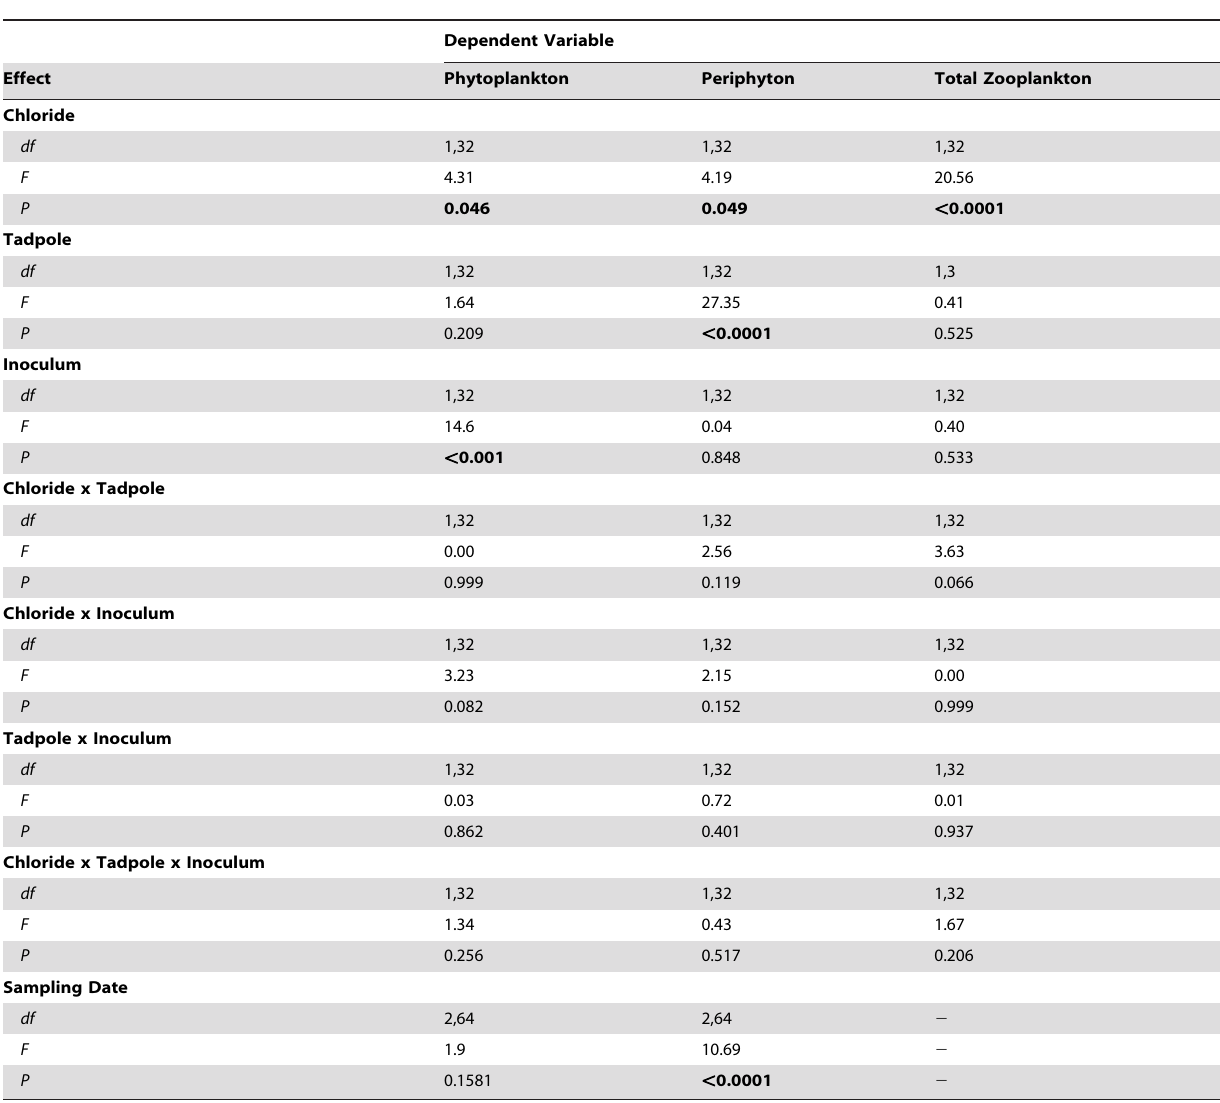
Table 3. Repeated measures analysis of variance (RMAVNOVA) with compound symmetry covariance structure on mean values of log 10 transformed phytoplankton abundance and periphyton abundance and analysis of variance (ANOVA) on mean values of log 10 transformed total zooplankton